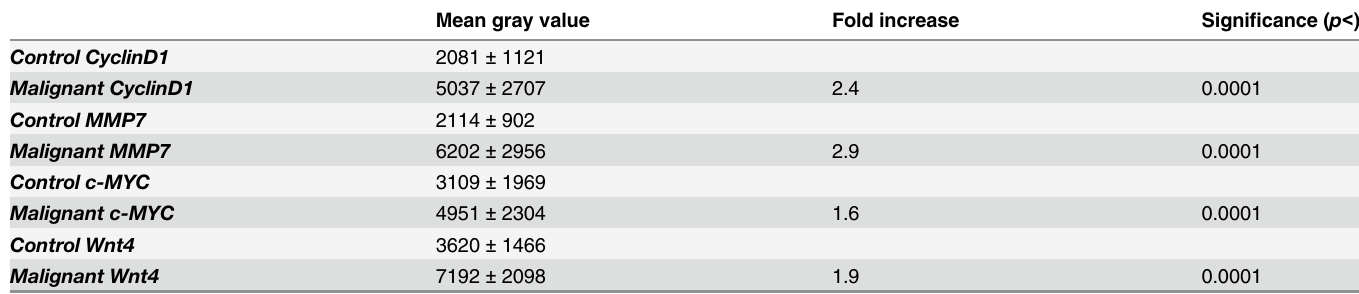
Table 1. Quantitative analysis of protein expression in PeCa.